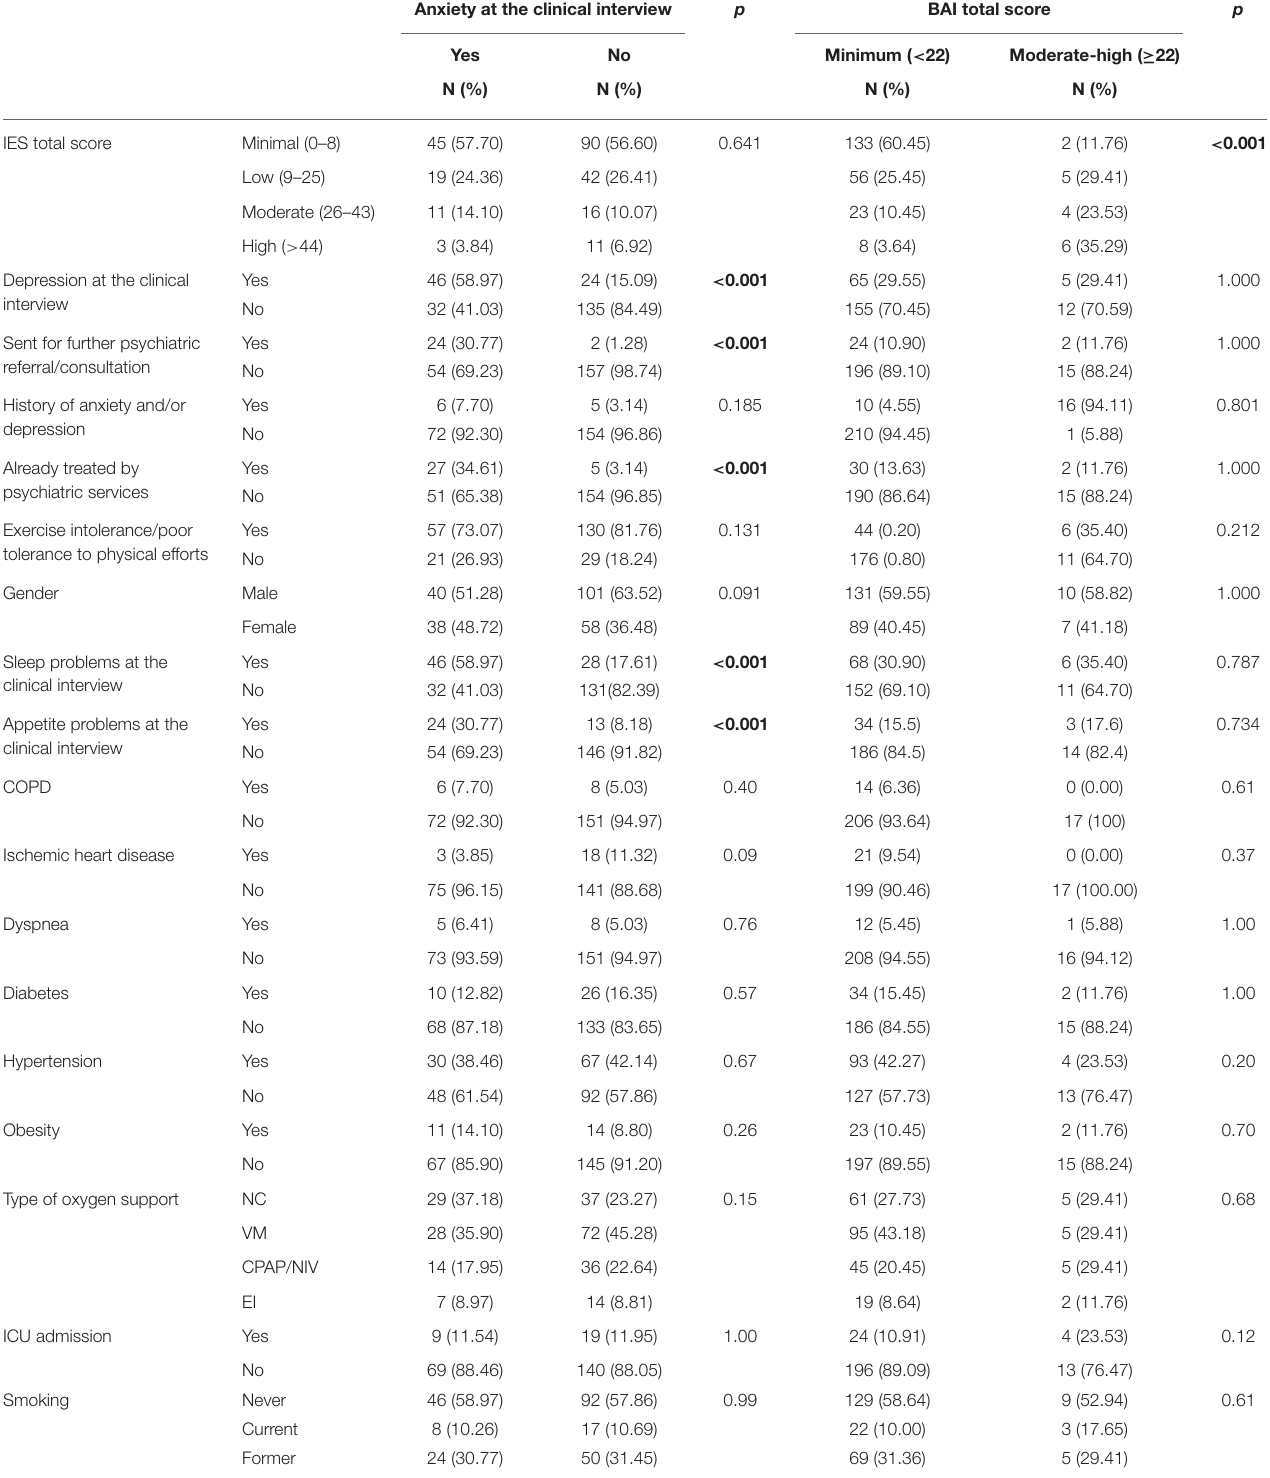
TABLE 1 | Anxiety as assessed at the psychiatric interview and with the BAI: chi squared test. Anxiety at the clinical